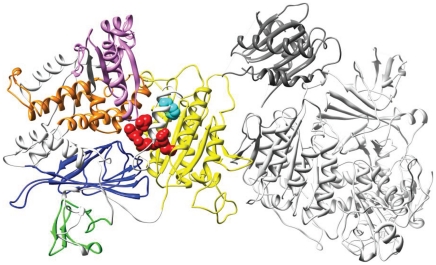
A model of the S. galil sec23a/sec24 hetero-dimer, color-coded by functional domains.The protein sec23a appears on the left in bright colors in its putative docked conformation with its sec24 partner (white and grey chains on the right). The 5 known domains are colored in yellow (trunk domain), green (zinc finger domain), violet (Gelsolin), orange (helical domain), and blue (beta-sandwich domain). Putative novel S. galili splice variant flanking amino acids (the start and end point of the new insertion) are presented in red spheres (the novel region is not modeled), and the F382L mutation in cyan spheres.